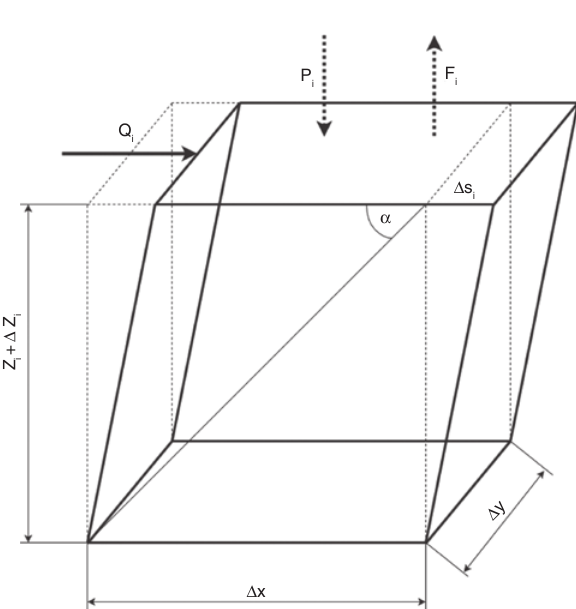
Figure 3: With a surface modeled as collection of parallel springs, one spring representing a cuboid of the surface material is shown. Δ x and Δ y are the dimensions of the cuboid in this model, assumed to be the size of the step set during surface topography measurement. Z the height of the layer, Q is the shearing force, while P and F are the load and adhesion forces that could stretch or compress z